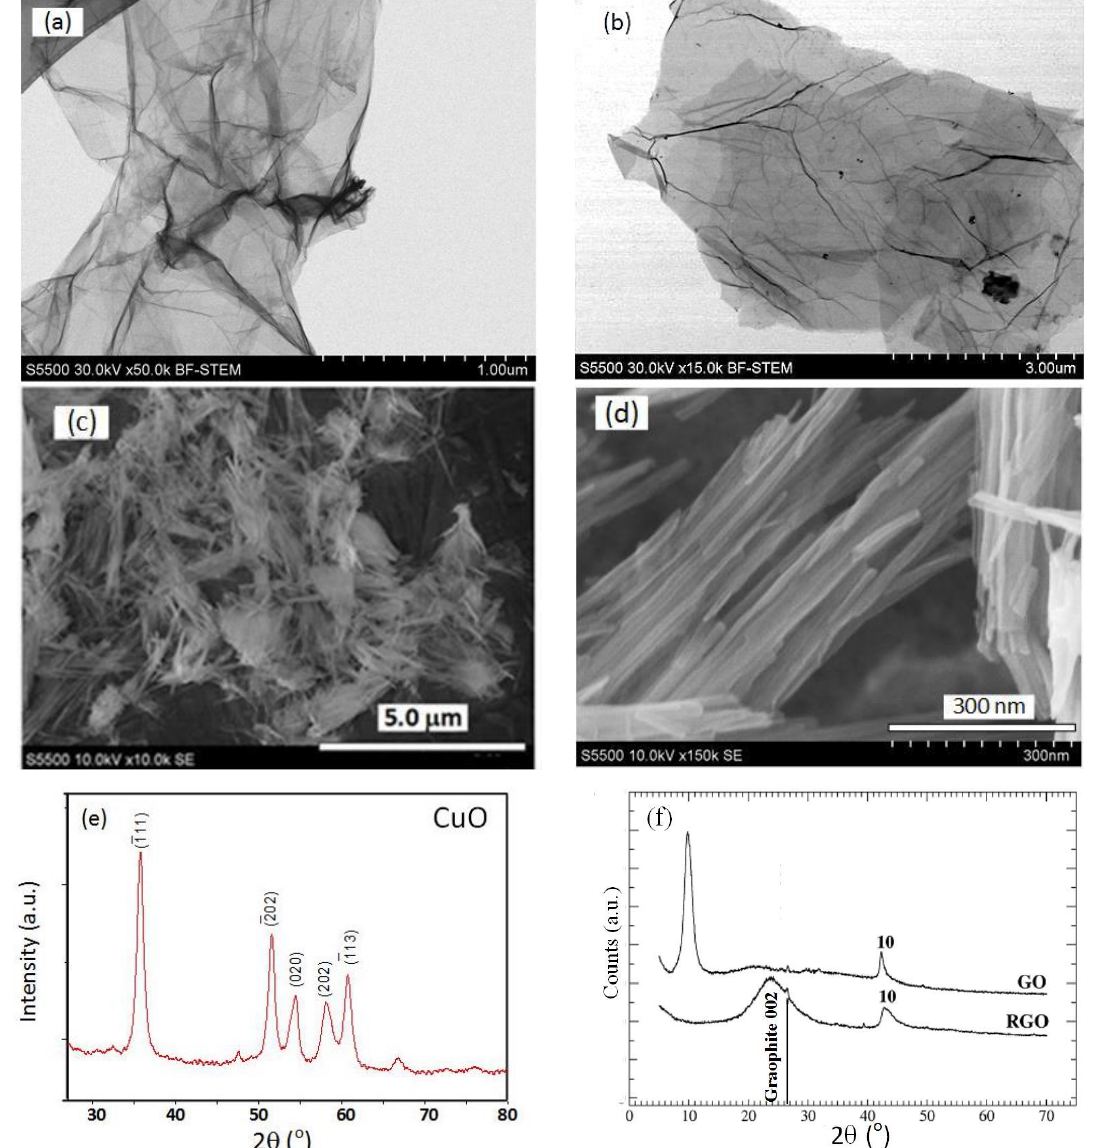
Figure 5. TEM images of GO ( a ) and rGO; ( b ) flakes; ( c ), ( d ) SEM images of CuO nanoparticles with different magnifications; ( e ) X-ray diffraction pattern of CuO; and ( f ) X-ray diffraction pattern for GO and rGO.